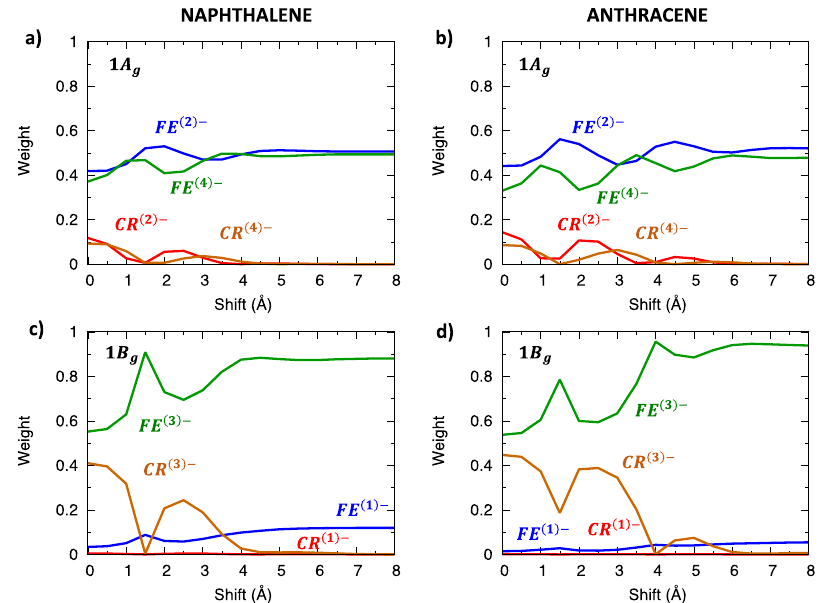
Figure 5. Wavefunction composition of the adiabatic lowest exciton states of (left) naphthalene and (right) anthracene in terms of the SA diabatic states defined in Figure 3. ( a , b ) 1𝐴 𝑔 state and ( c , d ) 1𝐵 𝑔 state. Red and brown lines represent the contributions to the total wavefunction of 𝐶𝑇 states, while green and blue lines represent the weight of 𝐿𝐸 states.